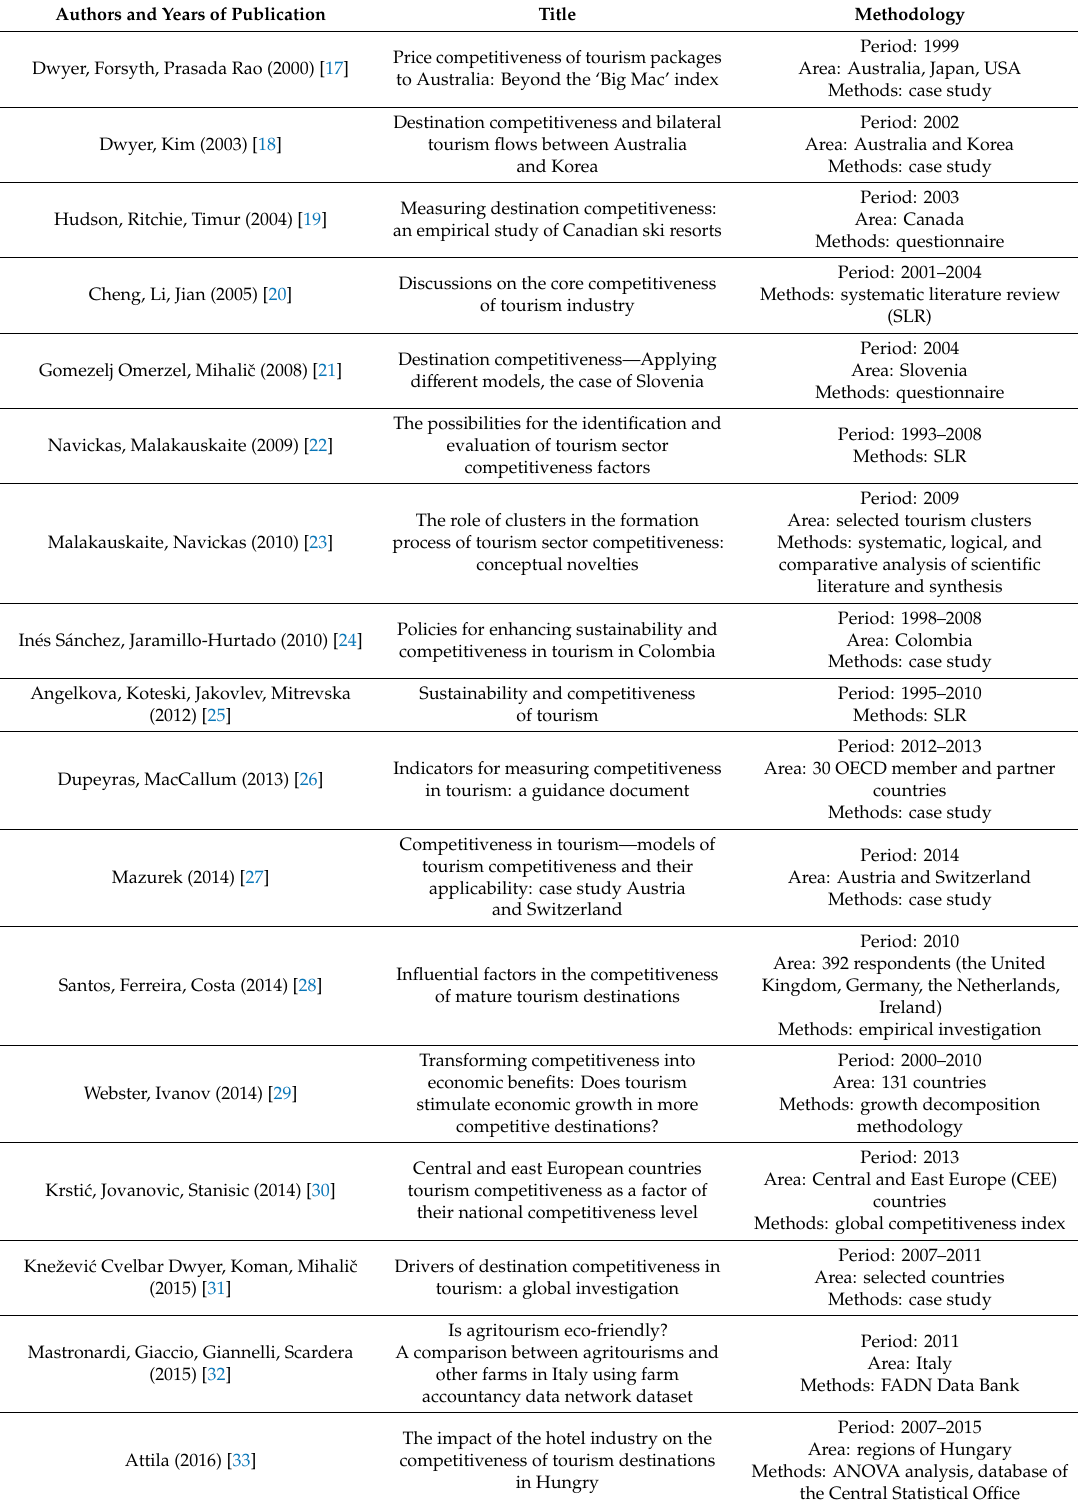
Table 2. List of publications on tourism competitiveness (according to the date of